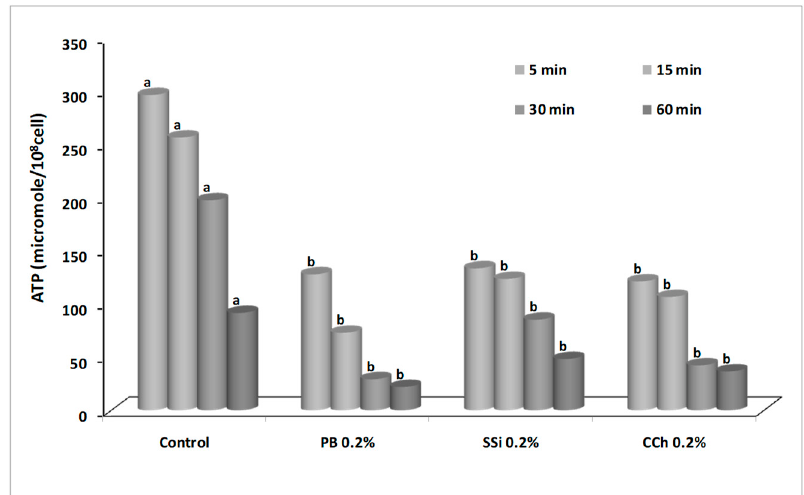
Figure 11. Effect of potassium bicarbonate (PB), sodium silicate (SSi), and calcium chelate (CCh) at 0.2% on ATP content of Botrytis cinerea conidia determined by luciferin/luciferase kit. The luminescence emission by the reaction was determined with a multi-mode detection microplate reader at different incubation time (5, 15, 30, and 60 min). Values marked with the same letters are not statistically different by Fisher’s protected least significant difference test at p ≤ 0.05.